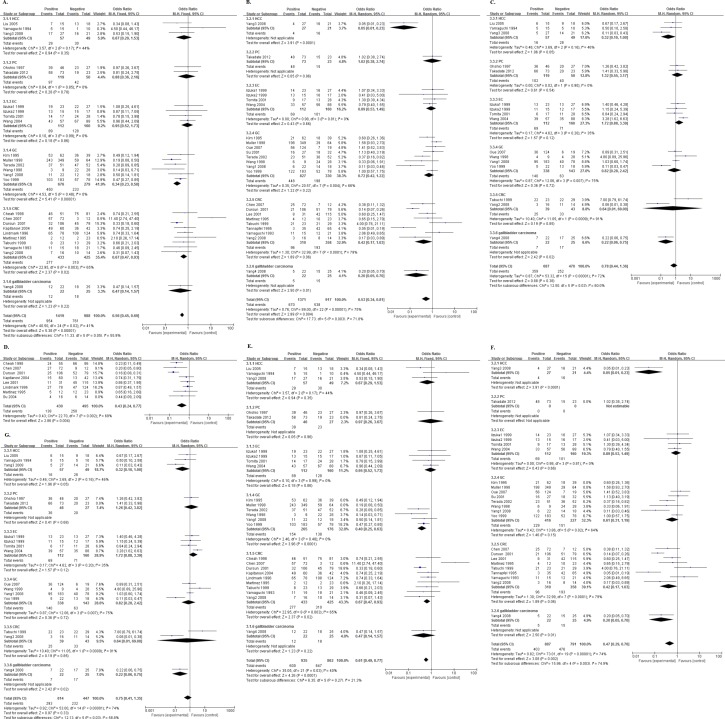
Forest plot of odds ratio (OR) for the association between NME1 overexpression and clinical pathological factors in patients with different tumor types with random effects model.A. The ORs for tumor differentiation; B. The ORs for N status; C. The ORs for TNM stage; D. The ORs for Dukes’ stage; E. The ORs for tumor differentiation without low cut-offs; F. The ORs for N status without low cut-offs; G. The ORs for TNM stage without low cut-offs.